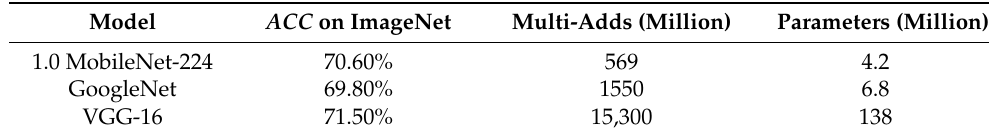
Figure 11. Depth-level separable convolution structure of MobileNet. Table 4. Performance of different models on ImageNet. Table 4. Performance of different models on ImageNet.